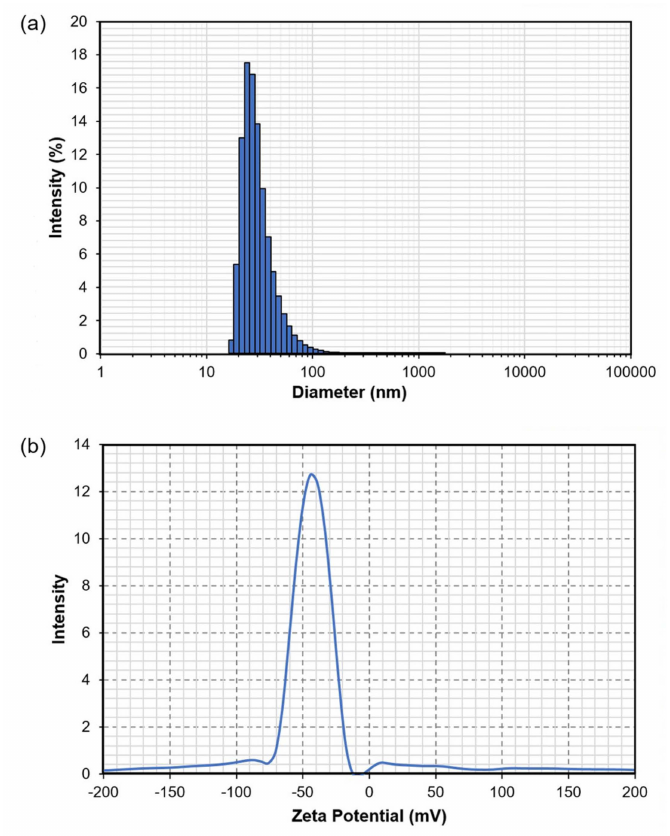
Figure 9. Distribution of ( a ) particle size and ( b ) Zeta potential of CNCs produced from banana peel using the one-pot